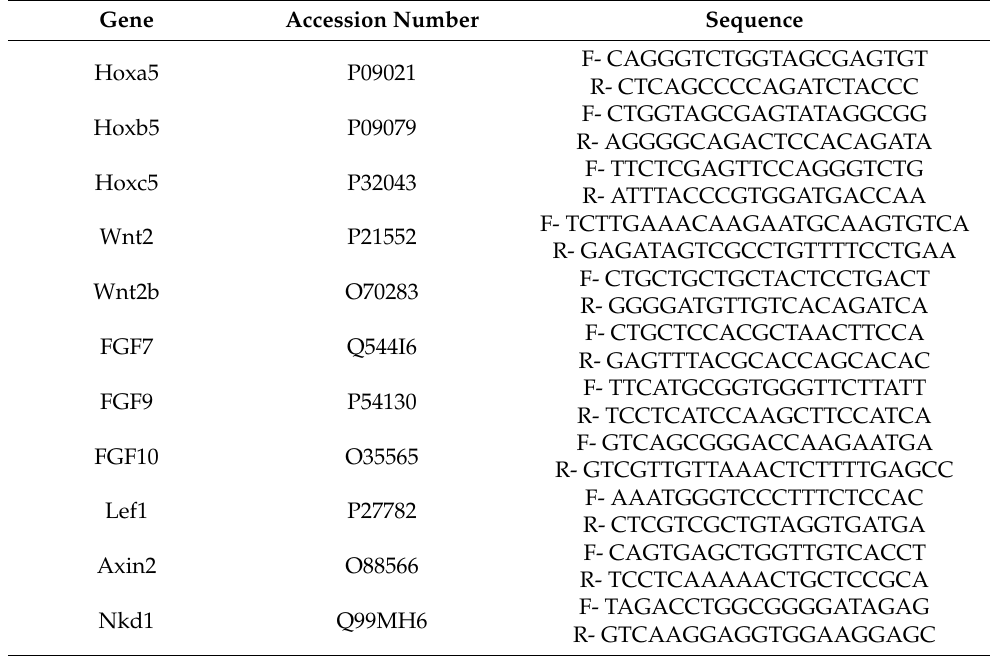
Table 1. Primers used for RT-qPCR assays in lung fibroblasts.